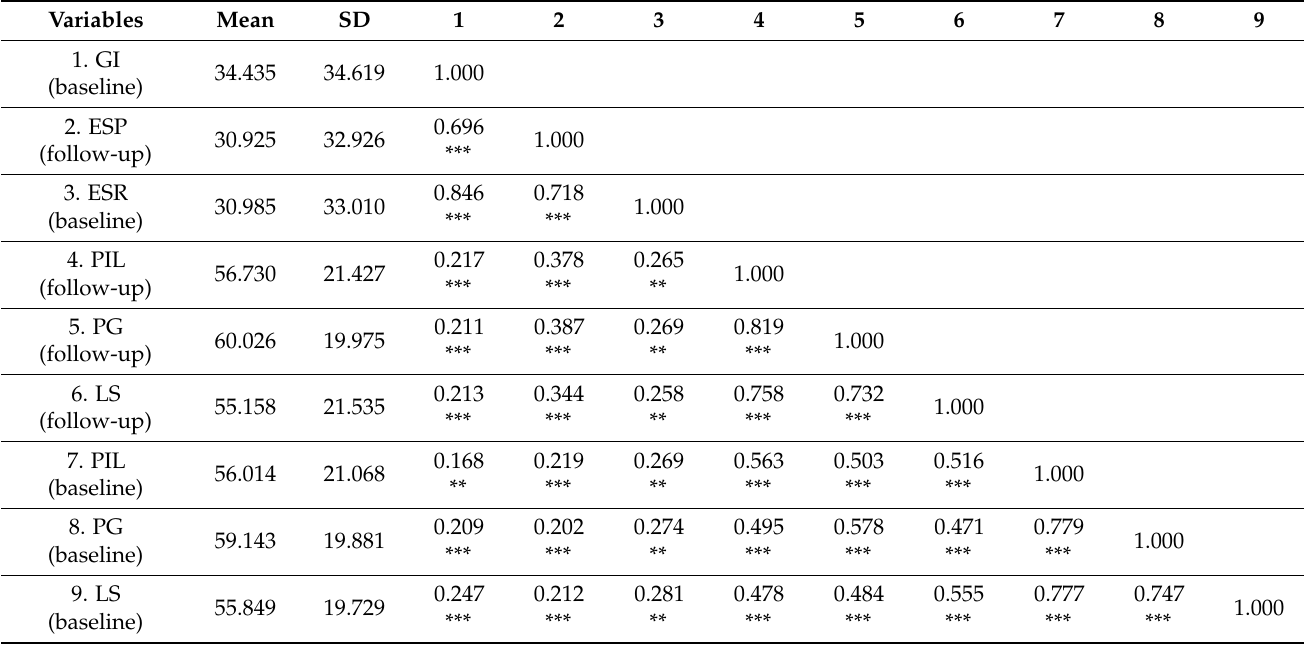
Table 2. Descriptive statistics and bivariate correlations of key variables.